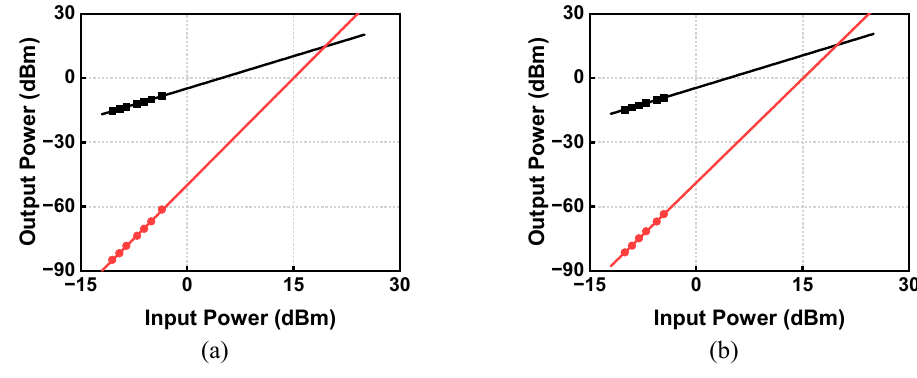
Figure 10. IIP3 measurements ( a ) TX to ANT; ( b ) ANT to RX.